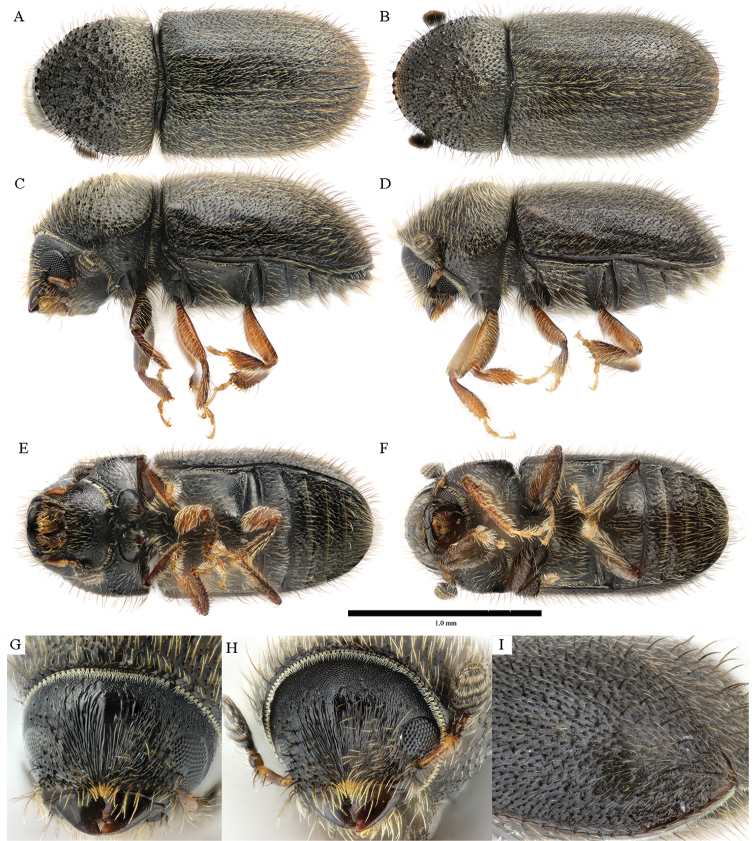
Cryphalus
lipingensisA, C, E, G female, UFFE:28042 B, D, F, H, I male, UFFE:28041.